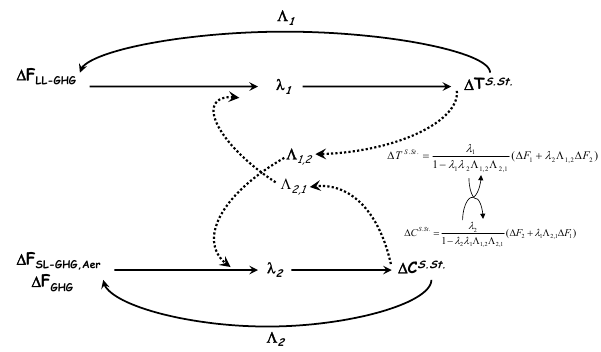
Fig. 1. Changes in forcing ( 1F ) yield a system response ( 1T ( T : temperature), 1C ( C : atmospheric concentration)) depending on its sensitivity ( λ) to 1F . Feedbacks ( 3) may dampen or amplify the original forcing. “1” denotes processes relevant to the climate, “2” those to the pollution-chemistry system. GHG: greenhouse gas, either long-lived (LL) or short-lived (SL). Aer: aerosol particles. S.St.: steady state. Forcings are exerted by anthropogenic, ocean and terrestrial processes. Since processes in the physical climate system and those in the pollution/atmospheric concentration system do not operate independently from each other, assessment of pro- portionality and feedback factors ( λ , 3 ) needs to account for both. The figure is adopted from Raes et al.